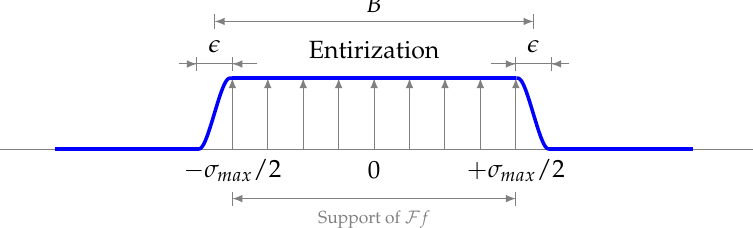
Figure A2. Entirization of a tempered distribution via finitization of its Fourier